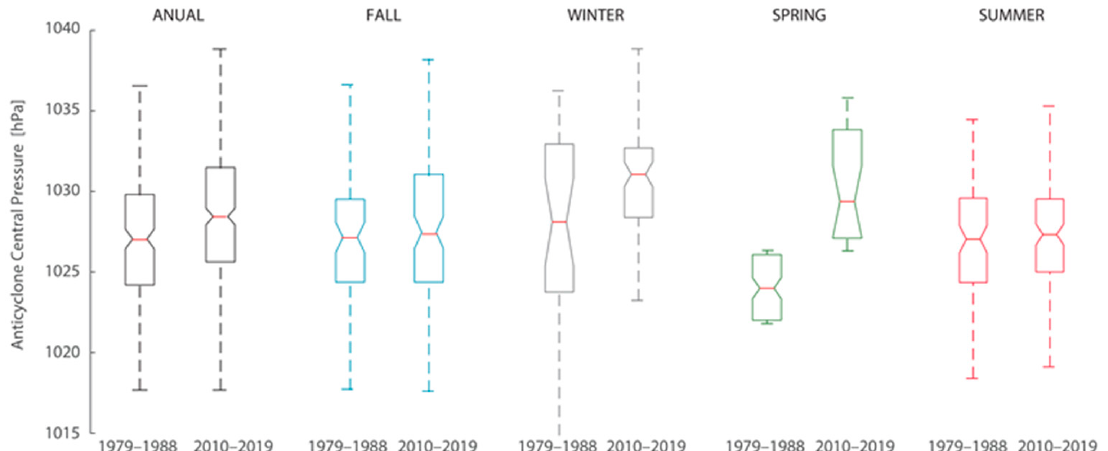
Figure 12. Comparison of the distributions of central pressure of migratory anticyclones inside the box defined in Figure 1 between periods 2010–2019 and 1979–1988 at each season and annual.